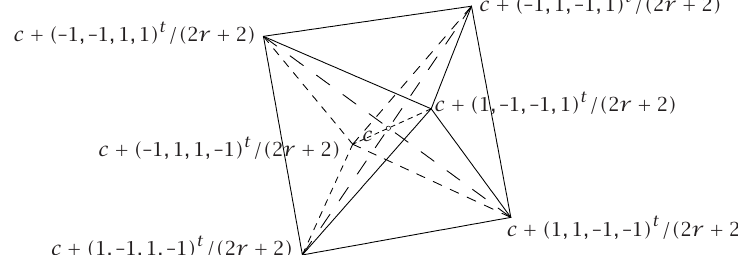
Figure 4.2 . Local figure of the decomposition of the octahedron in Figure 4.1(b) by adding c